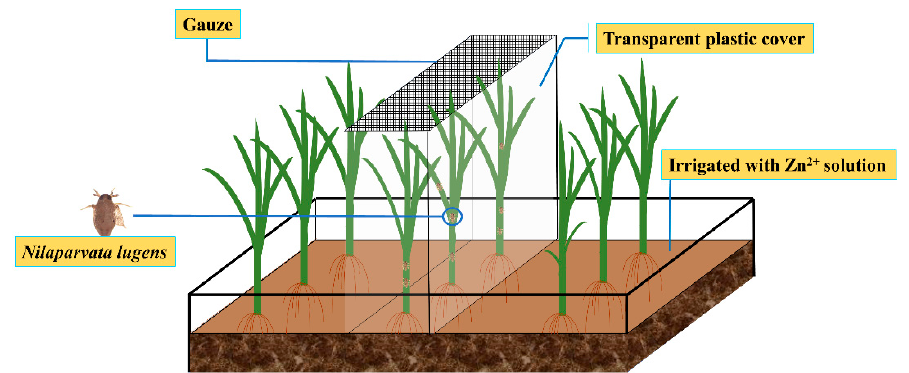
Figure 1. Zinc-treated soil–rice– Nilaparvata lugens pattern. Soil was irrigated with different concentra- tions of Zn 2+ solution (0, 75, 100, 125, and 150 mg · kg − 1 ). Three rice plants during the stooling stage in the middle of the plastic pot were covered with a clear plastic hard membrane, and the top was covered with gauze to ensure ventilation and prevent the N. lugens from escaping. Three emerging females and three males were put into the cover, and the adults were removed after free mating for 7 d.